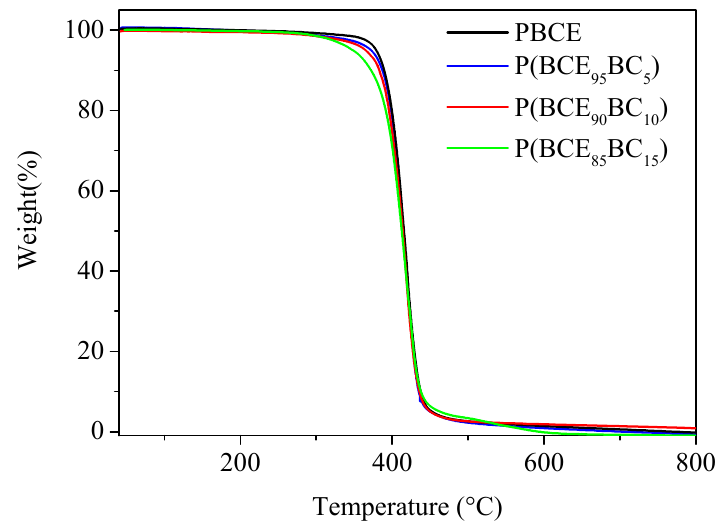
◦ C/min under N 2 flow.